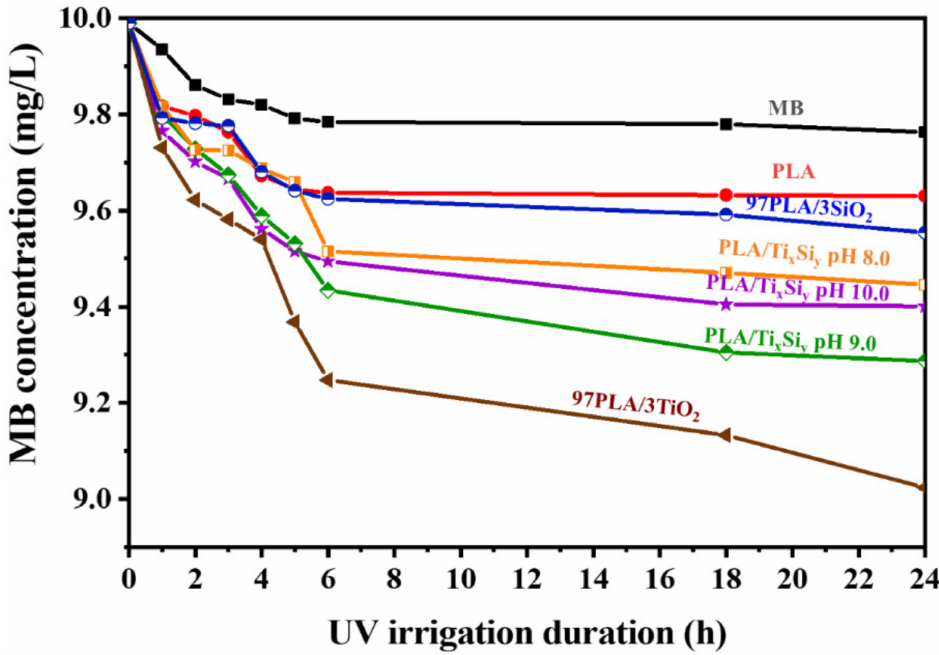
Figure 21. Concentration of methylene blue (MB) due to absorption of PLA film and PLA/Ti 50 Si 50 oxide (synthesized at pH 8.0, 9.0, and 10.0) films under UV irrigation.